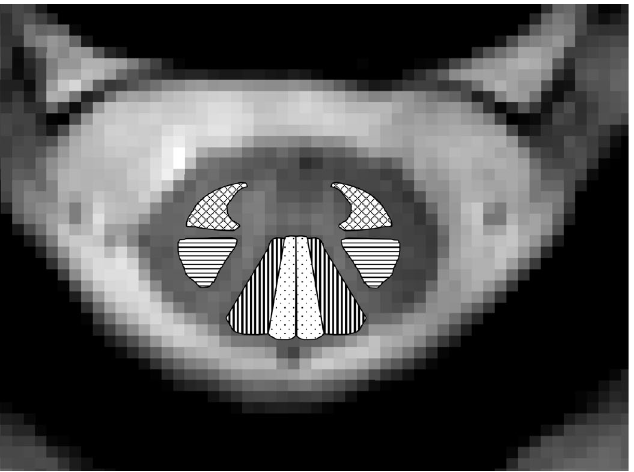
Figure 2. Example MR image from the C2/3 level, with highlighted bilateral large white matter tracts: corticospinal tracts (horizonal lines); cuneate fasciculi (vertical lines); gracile fasciculi (dotted); combined spinothalamic and spinoreticular tracts (crosshatched lines).